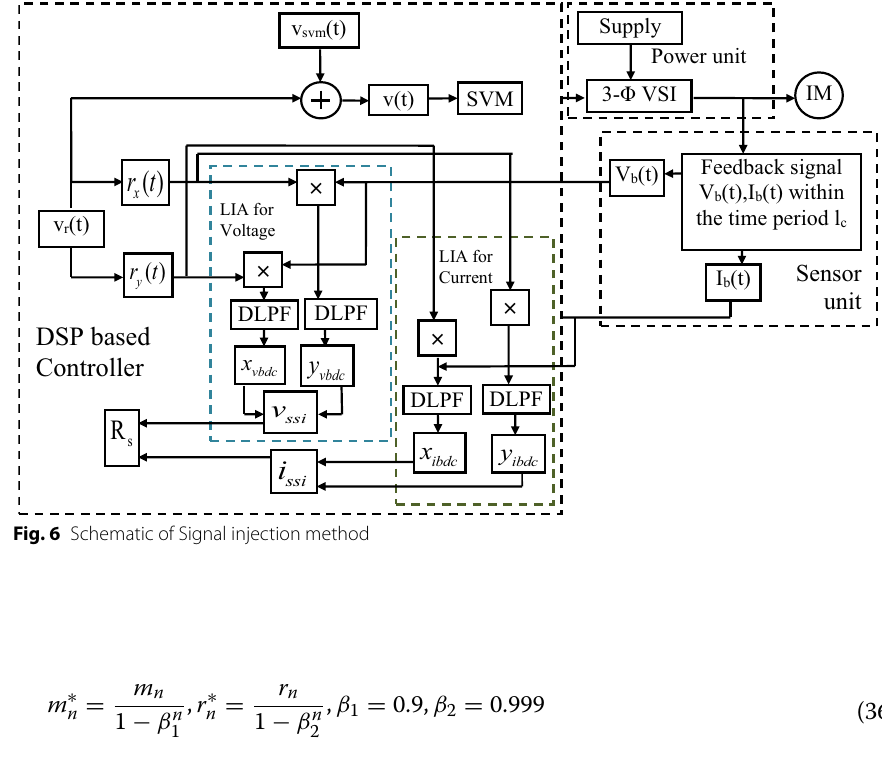
Fig. 6 Schematic of Signal injection